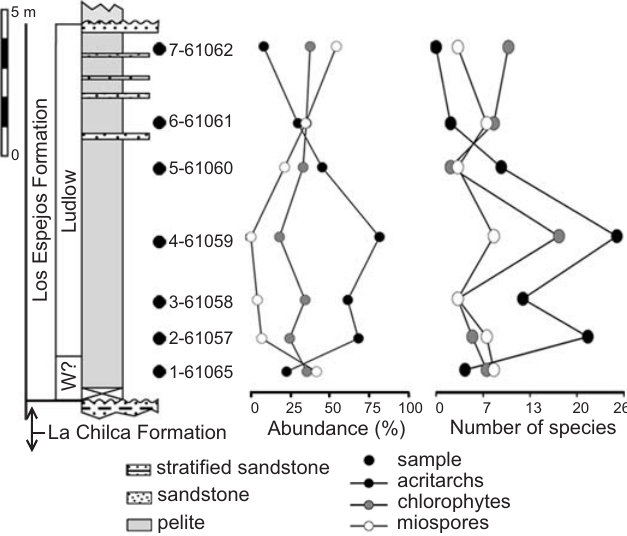
Fig. 2. Stratigraphic section of the Los Espejos Formation in Cerro La Chilca, showing relative abundance (%) and diversity (number of species) of acritarchs, chlorophytes, and miospores per sample. W?: Wenlock?